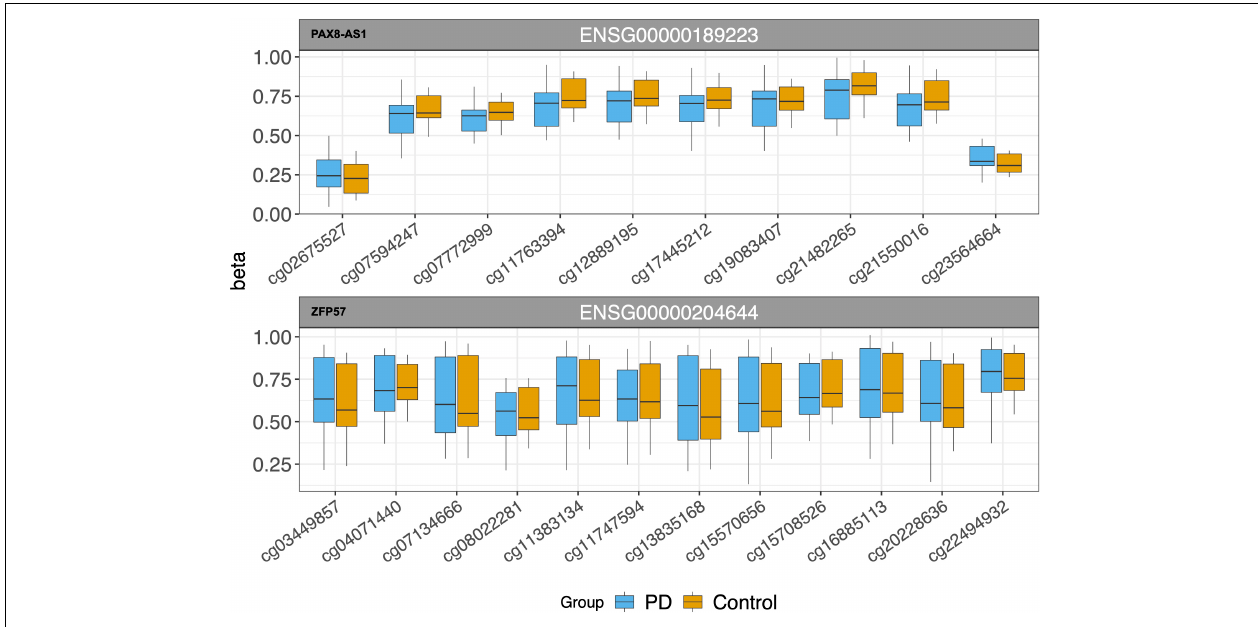
FIGURE 3 | cis -eQTMs for multiple CpG sites near two genes ( PAX8-AS1 and ZFP57